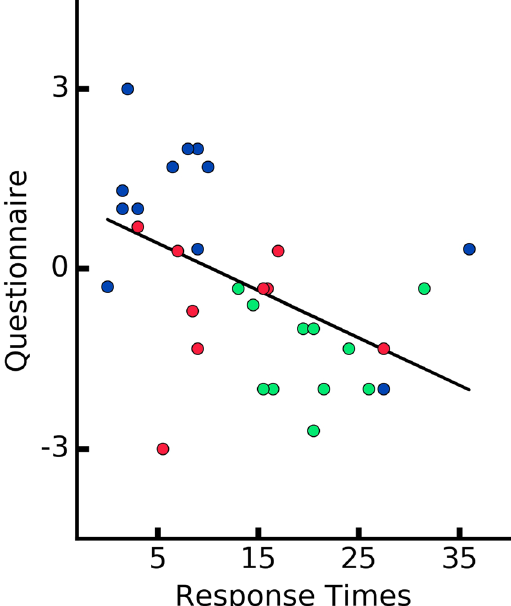
Figure 9. Correlation between the motor performance and self-reports (mean of the three ownership questionnaire for each